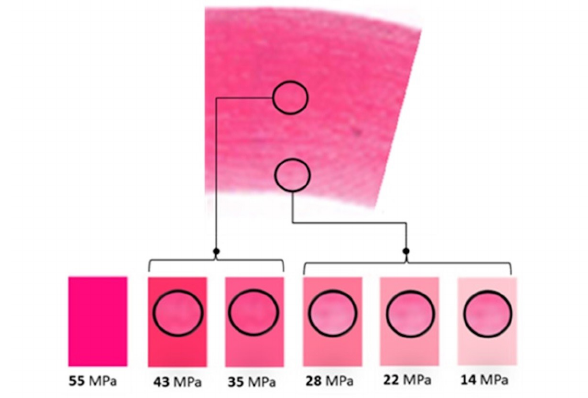
Figure 20: Contact stress distributions on the FUJI film in case of joint gasketed with FG_2 material and state I-0 as well as load cor- responding to tightness L1.0